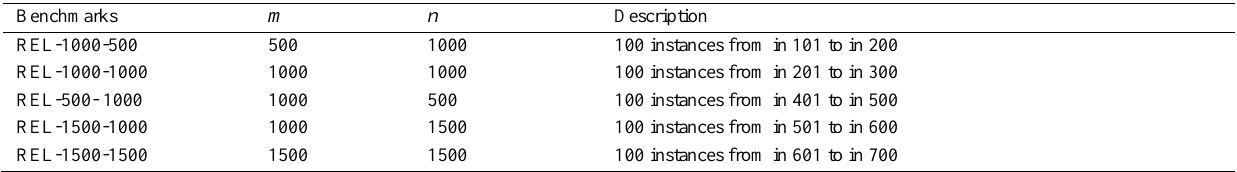
Table 1. Main characteristics of benchmarks